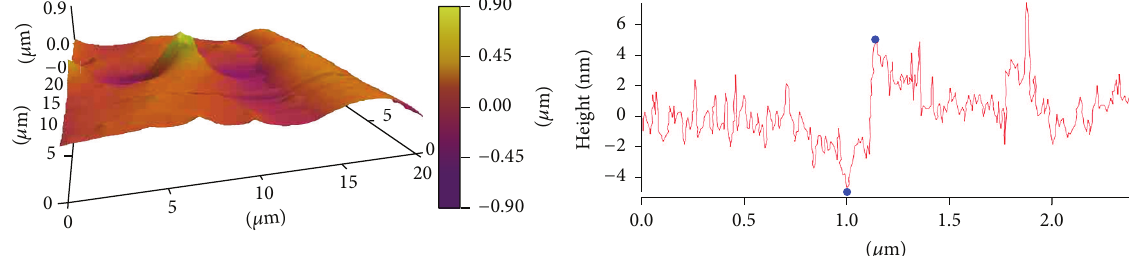
Figure 3: 3D-AFM characterization of PET surface topography and adhesion of salmon tissue residues.